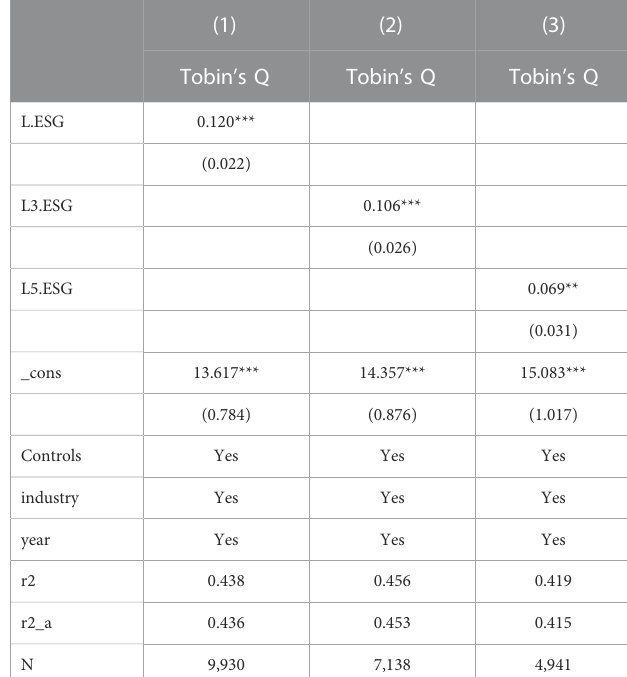
TABLE 10 Lagged effect